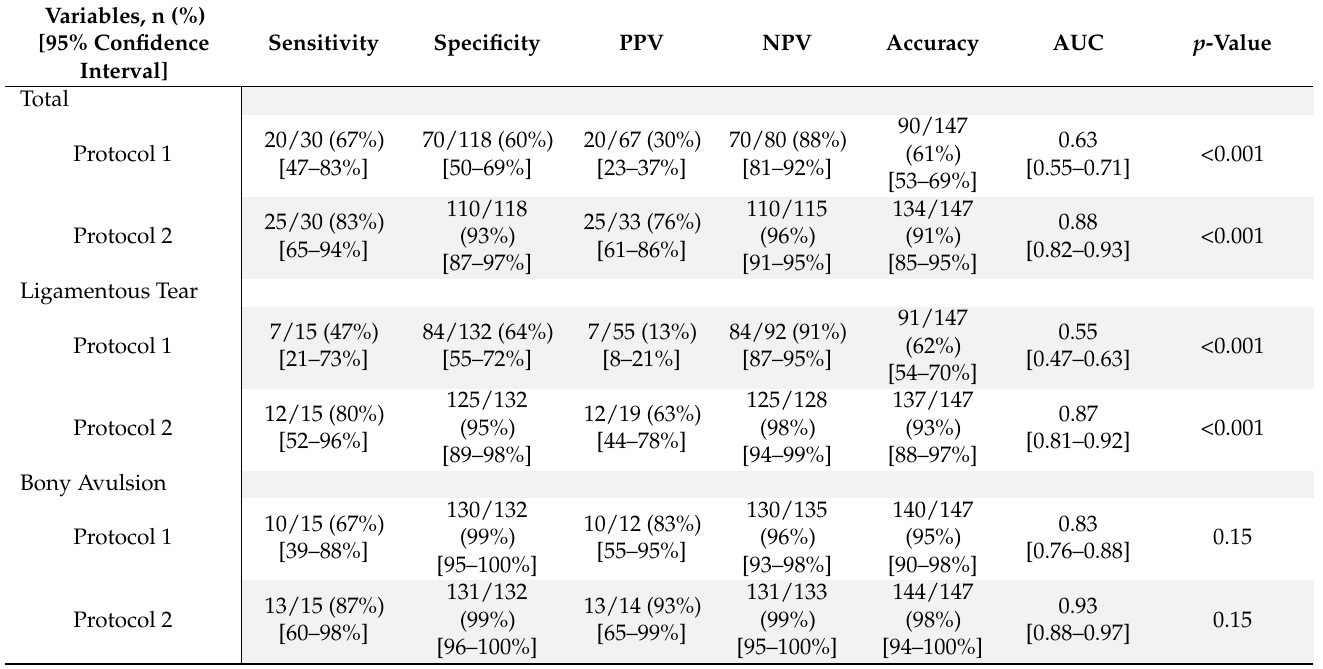
Table 2. Diagnostic accuracy of standard grayscale CT and color-coded collagen mapping for syndesmotic injury.